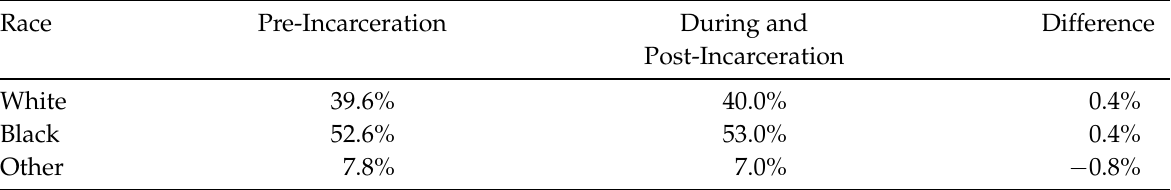
Table 2: Average racial classifications for ever-incarcerated respondents . From the National Longitudinal Survey of Youth,